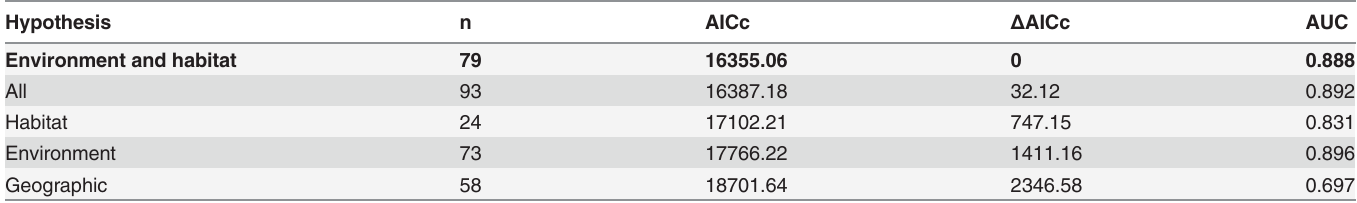
Table 3. Results of AICc model selection for adult monarchs.